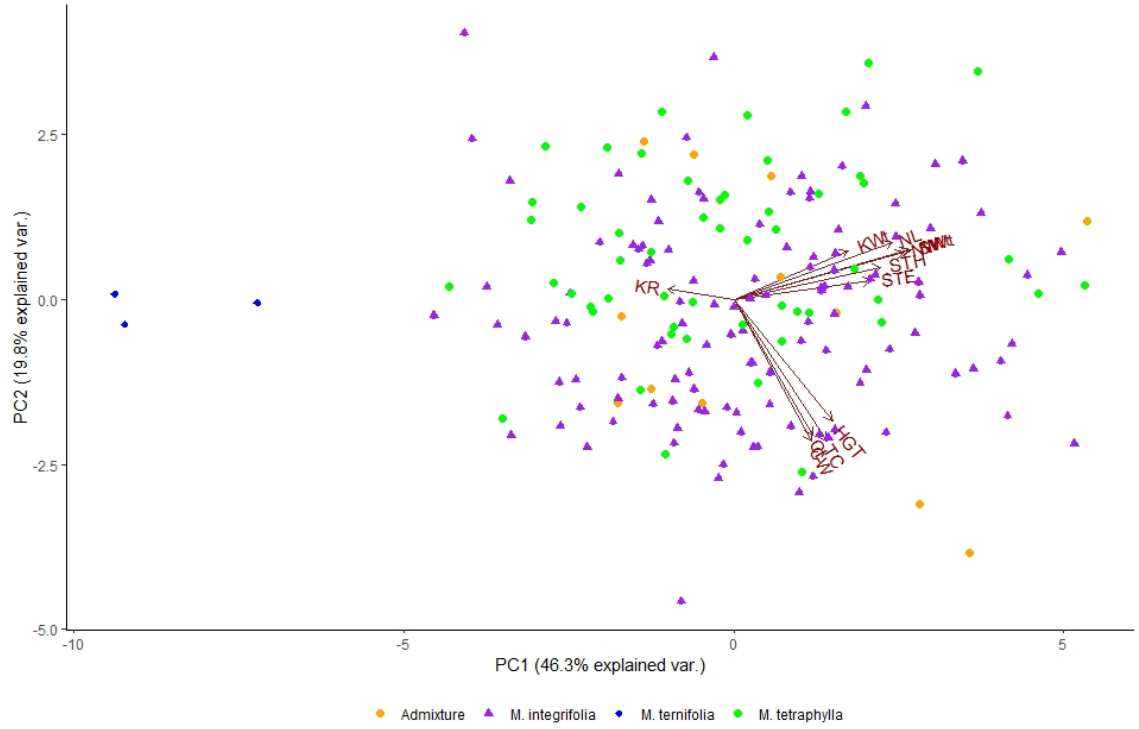
Figure 1. Biplot of trait loadings and accession scores for PC1 and PC2 of the growth and nut traits in wild accessions of different species. HGT = Tree height, TC = Trunk circumference, CL = Canopy length, CW = Canopy width, NWt = Nut weight, NL = Nut length, NW = Nut width, STH = Shell thickness at hilum, STE = Shell thickness at equator, SWt = Shell weight, KWt = Kernel weight, KR = Kernel recovery. The red arrows represent different traits. Dots indicate accessions. Vectors of NWt, NW, and SWt were overlapped due to high correlation among these traits.